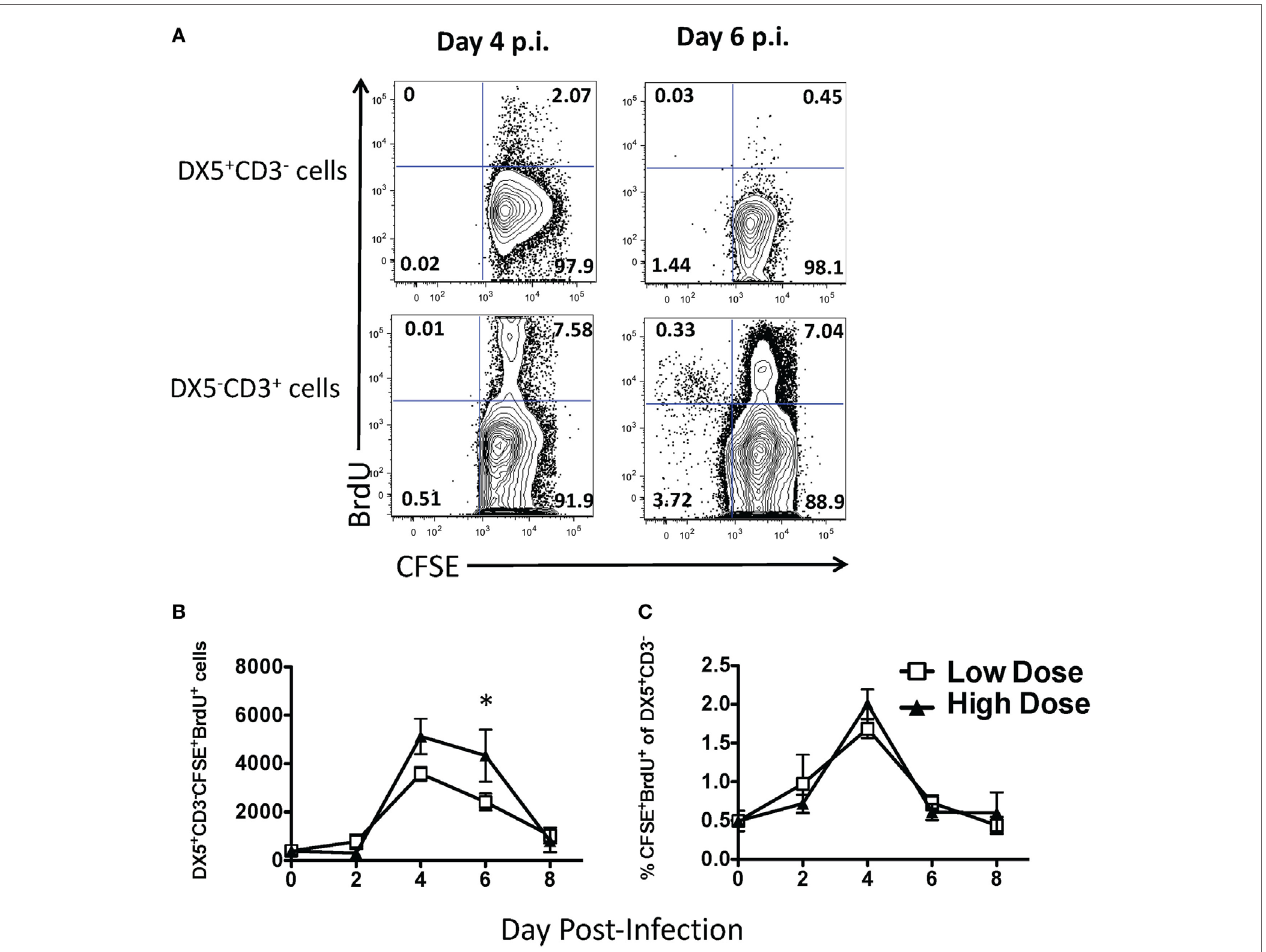
FigUre 2 | Small frequency of natural killer (NK) cells proliferate in the lung during low- and high-dose influenza A virus (IAV) infections. BALB/c mice were infected with either a high- or low-dose IAV infection and administered carboxyfluorescein succinimidyl ester (CFSE) and bromodeoxyuridine (BrdU) intranasally on the day of analysis, as described in Section “Materials and Methods.” (a) Representative flow plots for NK cells (DX5 + CD3 ε − gated) and T cells (DX5 − CD3 ε + gated) in the lungs of day 4 or 6 low-IAV dose-infected mice. The (B) number and (c) frequency of proliferating NK cells (i.e., the percentage of all DX5 + CD3 ε − cells that were also CFSE + BrdU + ) was determined by flow cytometry. The p -values comparing high- vs. low-dose IAV-infected animals are shown. * p < 0.05 (two-tailed unpaired Student’s t -test). Data are pooled from three high-dose experiments and two low-dose experiments, with five mice per group, per time